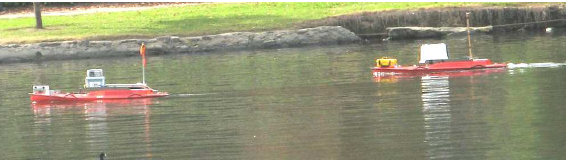
Figure 12. Two autonomous surface vessels of the Robotic Embedded Sys- tems Laboratory at USC. Courtesy of prof. Gaurav